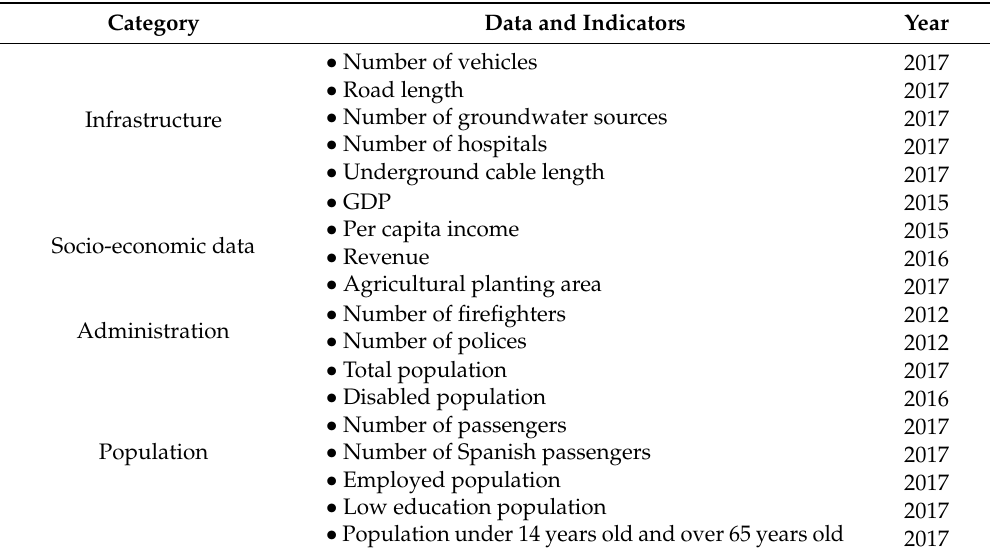
Table 2. Data used for social vulnerability